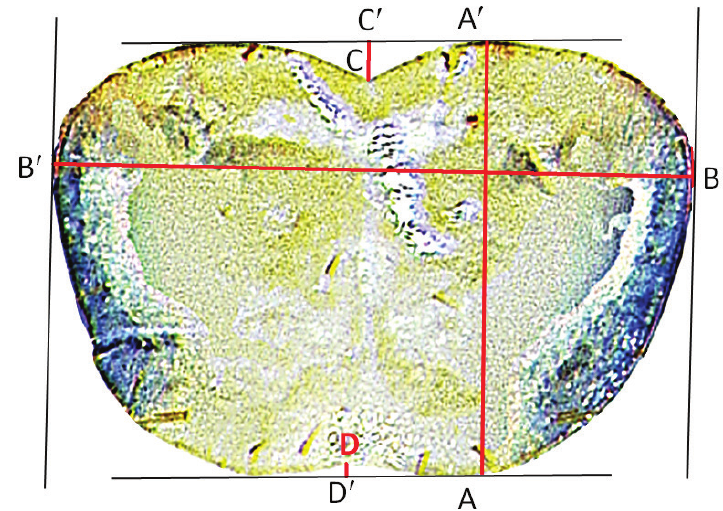
Figure 2. Pronotal metrics: AA'= maximum length of pronotum; BB' = maximum width of pro- notum; CC' = depth of anterior pronotal notch; DD' = depth of posterior pronotal notch. Parallels are marked in